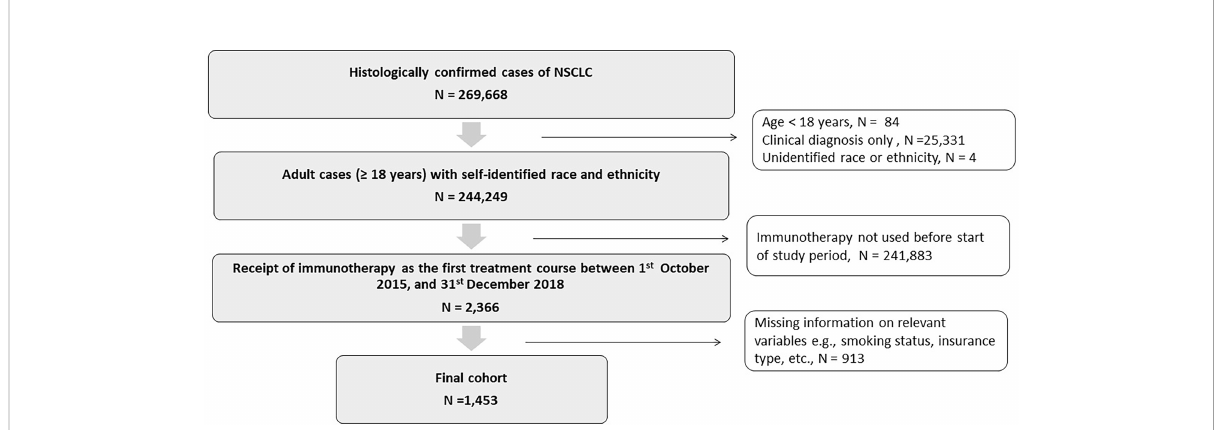
FIGURE 1 Consort diagram showing cohort selection: Patients 18 years and older with histologically con fi rmed cases of non-small cell lung cancer who received immunotherapy as the fi rst treatment course between October 1, 2015, and December 31,